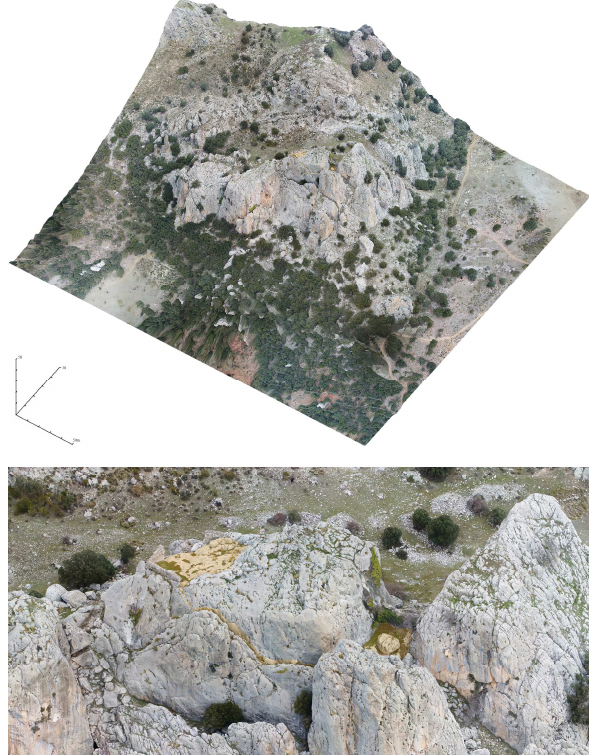
Figure 2. 3D photogrammetric model of the fortress of Cabrera. General view and detail of the location of the fortress, on the top of the rocky hill.